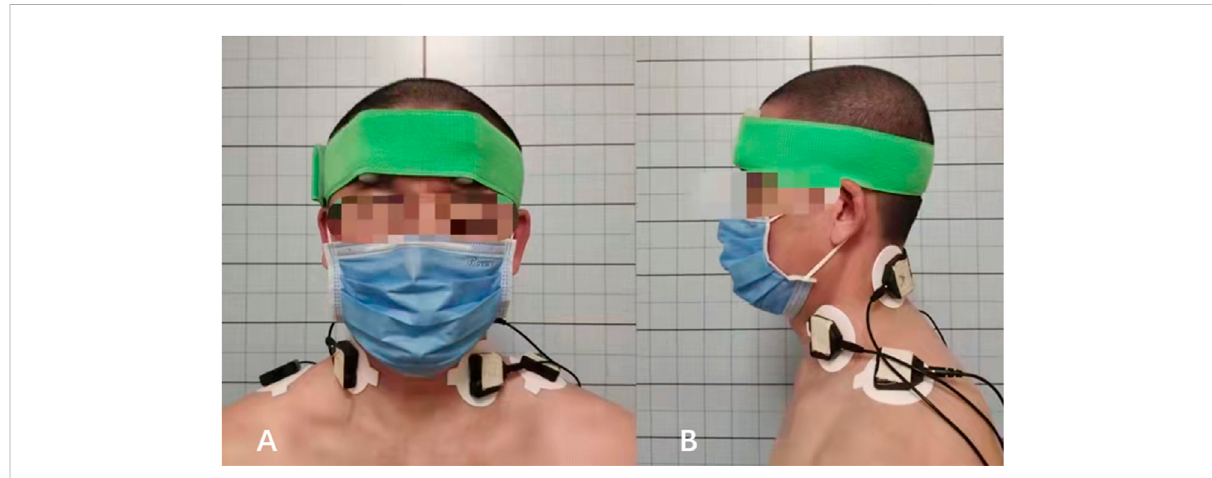
FIGURE 3 SEMG test of the cervical rotators. (A) The anterior view on the surface location of the electrodes, the electrode for SCM was located at the midpoint of the muscle; (B) The lateral view on the surface location of the electrodes, the electrode for SPL was located 2 cm from the spinous processattheC4level,andelectrodeforUTRwaslocatedatthemidpointofalinebetweentheC7spinous processandthemiddleoftheacromion.